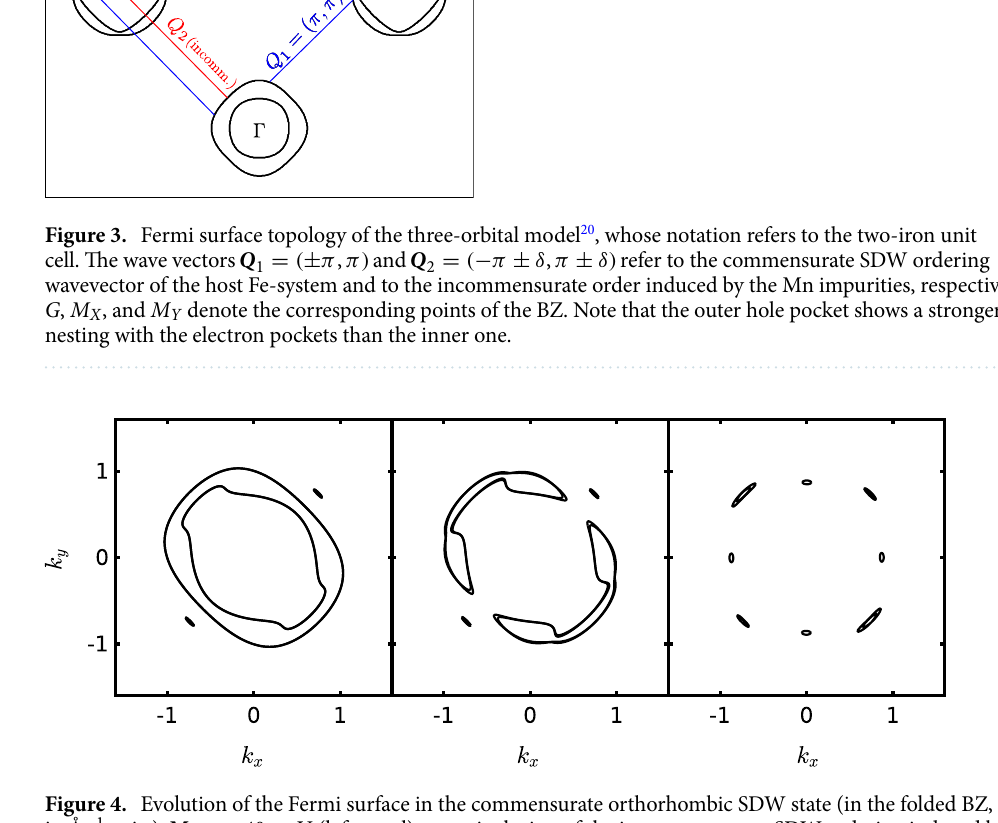
Figure 4. Evolution of the Fermi surface in the commensurate orthorhombic SDW state (in the folded BZ, in Å − 1 units), M X , c = 40 meV (left panel), upon inclusion of the incommensurate SDW ordering induced by RKKY interactions among Mn impurities and the corresponding renormalization of the chemical potential for M Y M X M Y M X , ic / , c ≈ 0.45 (mid panel) and , ic / , c ≈ 0.91 (right panel). See text for